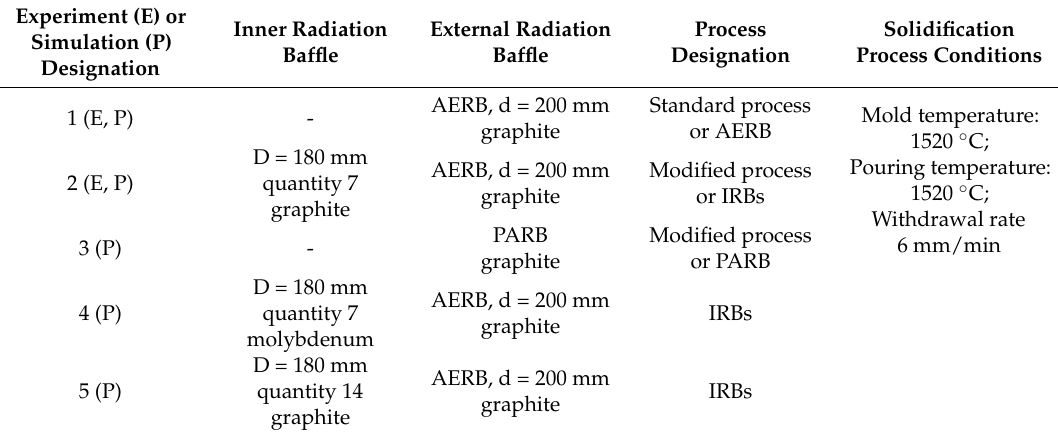
Table 1. Process conditions for experiments (E) and numerical simulations (P)